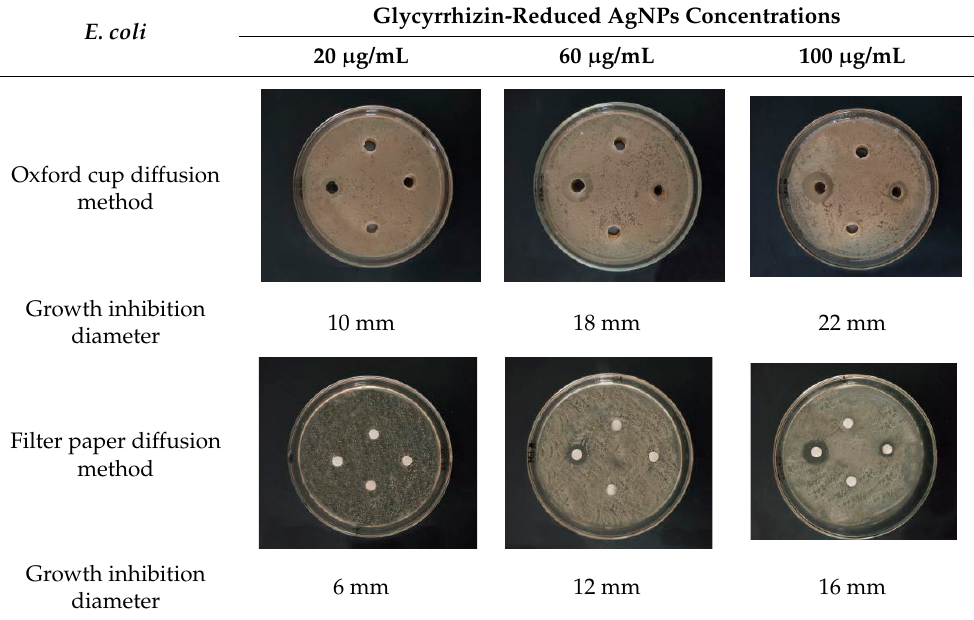
Table 1. Bacteriostatic diagram of GL-reduced AgNPs ( E. coli ).